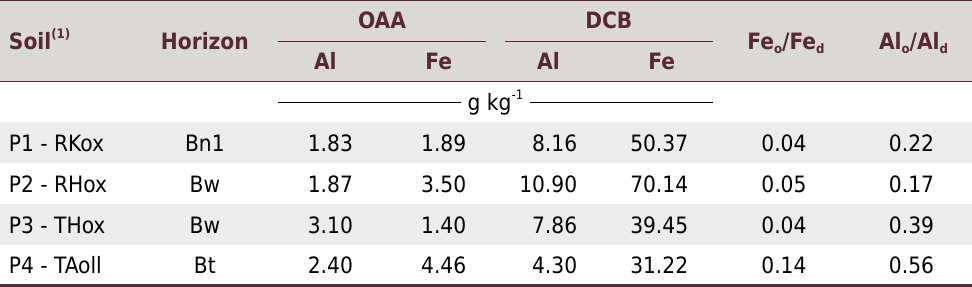
Table 4. Iron, aluminum, and manganese contents for the ammonium oxalate (OAA) and dithionite- citrate-bicarbonate (DCB) extracts, and Fe o /Fe d and Al o /Al d ratios for samples from soils of the Southern Espinhaço Mountain Chain and Upper Jequitinhonha